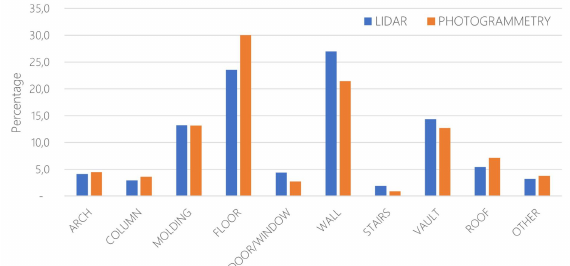
Figure 9 . Distribution of the classes in the two